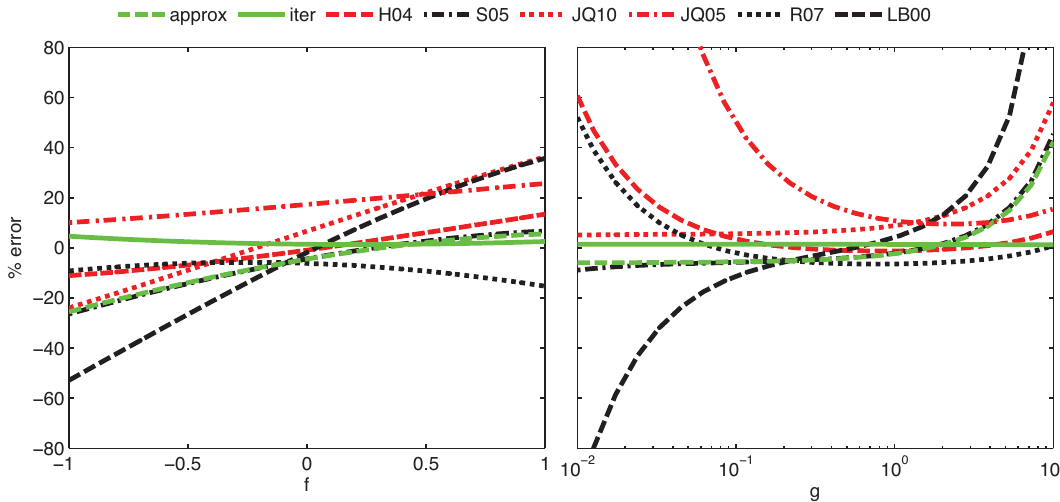
Fig. 1. Relative deviation of g from the “corrected base case” as calculated using the equation proposed by Kaiser. All values are the same as Kaiser’s base case except 17 δ P = − 11 . 588‰ instead of 17 δ P = − 11 . 646‰ as described in Sect. 3. The dashed green line “approx” shows error when “modified base case” values are used with the approximate equation from Luz and Barkan (2000) (Eq. 5) and 17 1 # (λ = 0 . 5179 ) . The solid green line “iter” shows error due to using the corrected “base case” values ( 17 δ P = − 11 . 588‰, 18 ε R = − 20‰ and λ = 0 . 5179 ) with the iterative method from Hendricks et al. (2004). Red and black lines show deviation from base case using the parameters and approaches employed in previous studies (see Table 3 in Kaiser, 2011 for details). They are calculated from the same values as used by Kaiser, except now compared against the “corrected base case”. Within typical oceanic conditions ( − 0 . 1 < f < 0 . 4 and 0.01 < g < 1), the methods generally agree within ± 20%. The following abbreviations are used to refer to previous studies: (H04: Hendricks et al., 2004; S05: Sarma et al., 2005; JQ10: Juranek and Quay, 2010; JQ05: Juranek and Quay, 2005; R07: Reuer et al., 2007; LB00: Luz and Barkan, 2000;